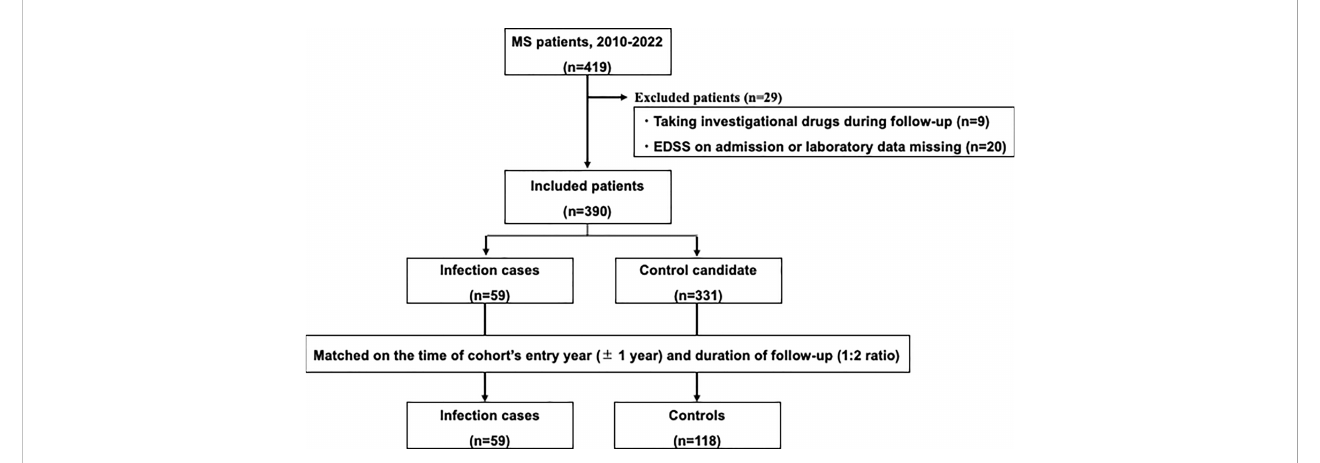
FIGURE 1 Study fl ow chart. Among patients with multiple sclerosis in the study hospital, patients with serious infections needing hospitalization were matched with controls without serious